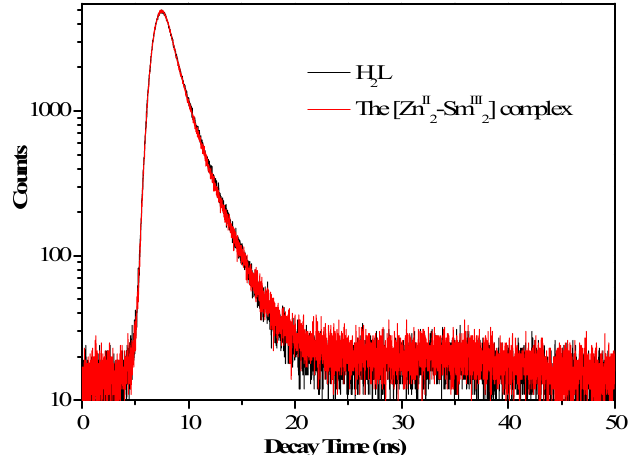
II III 2 –Sm 2 ] complex.